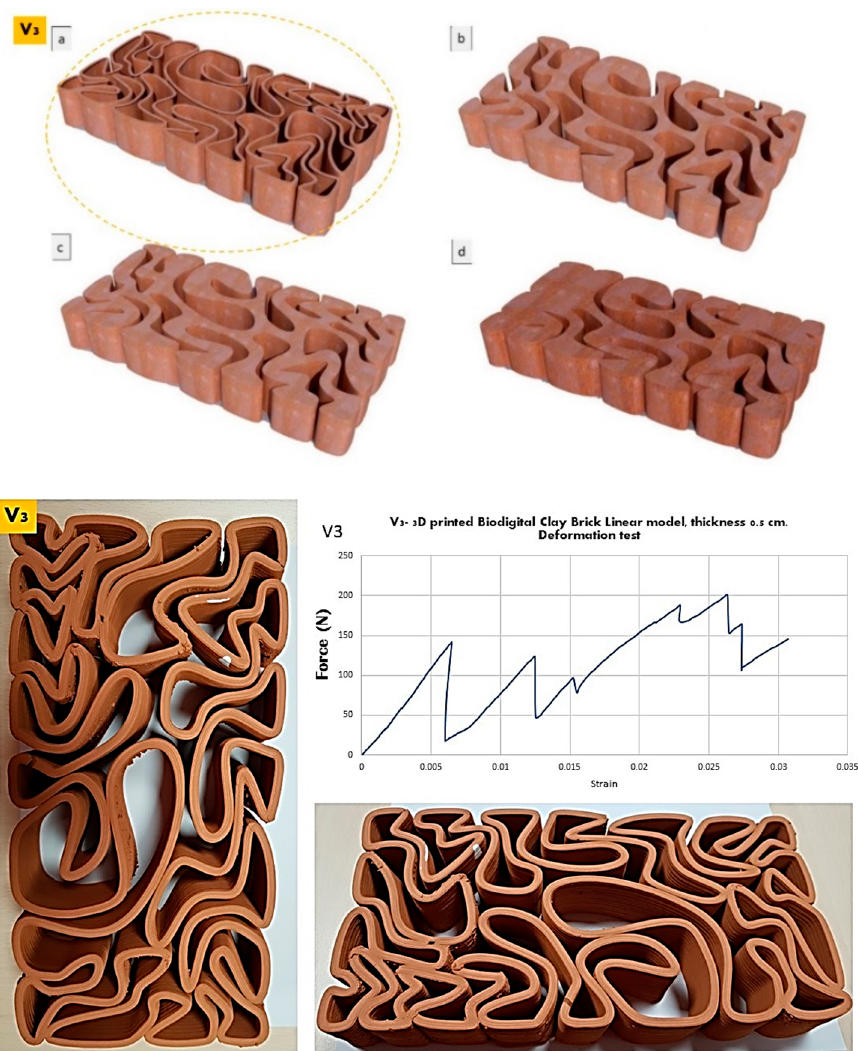
Figure 8. Exhibits the linear brick model of the V3 family of the biodigital clay bricks with double line linear thickness of 0.5 cm in 3D renders ( top ) as ( a ) is the tested linear brick model while ( b – d ) are the bulk models of the same family with variant densities. and in physical 3D-printed model ( bottom ). The graph exhibits the results of the deformation test for this brick, showing the relation between force (N) ( Y -axis) and strain ( X -axis). The V3 linear model exhibited the highest strain of 0.005 under 150 N pre-cracking and the highest strain of 0.026 under 200 N post-cracking. This was the best elasticity among all three linear brick models of the biodigital clay